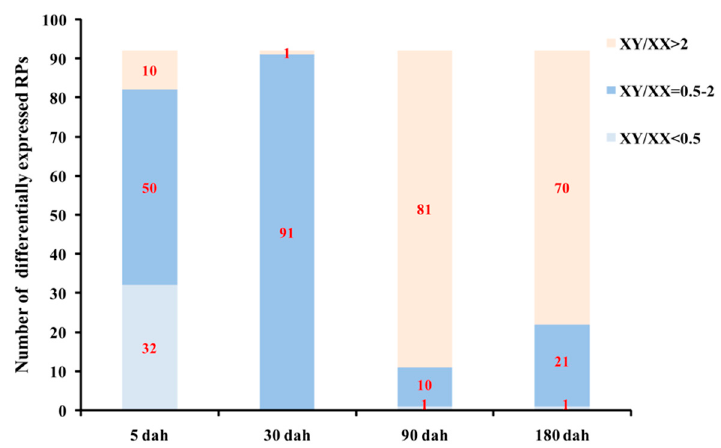
Figure 7. Number of differentially expressed RPs in XX and XY gonads of tilapia at 5, 30, 90 and 180 dah.XY/XX ratio was measured by RPKM values.